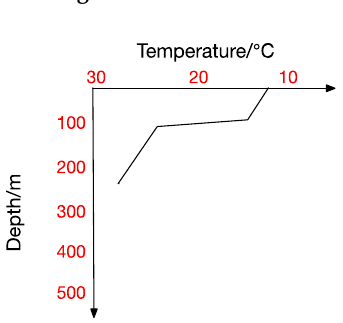
Figure 2. Thermocline.